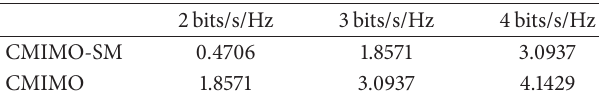
Table2: 𝛼 configurationsfor2 bits/s/Hz,3 bits/s/Hz,and4bits/s/Hz transmissions using CMIMO-SM and CMIMO.